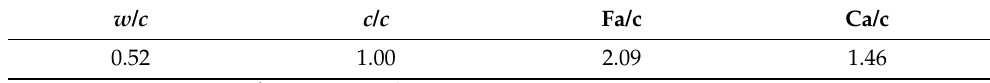
Table 1. This dose with 0% stock for f (cid:48) c = 200 kgf/cm 2 , coarse aggregate 3/8 (cid:48)(cid:48) . w / c c / c Fa/c Ca/c 0.52 1.00